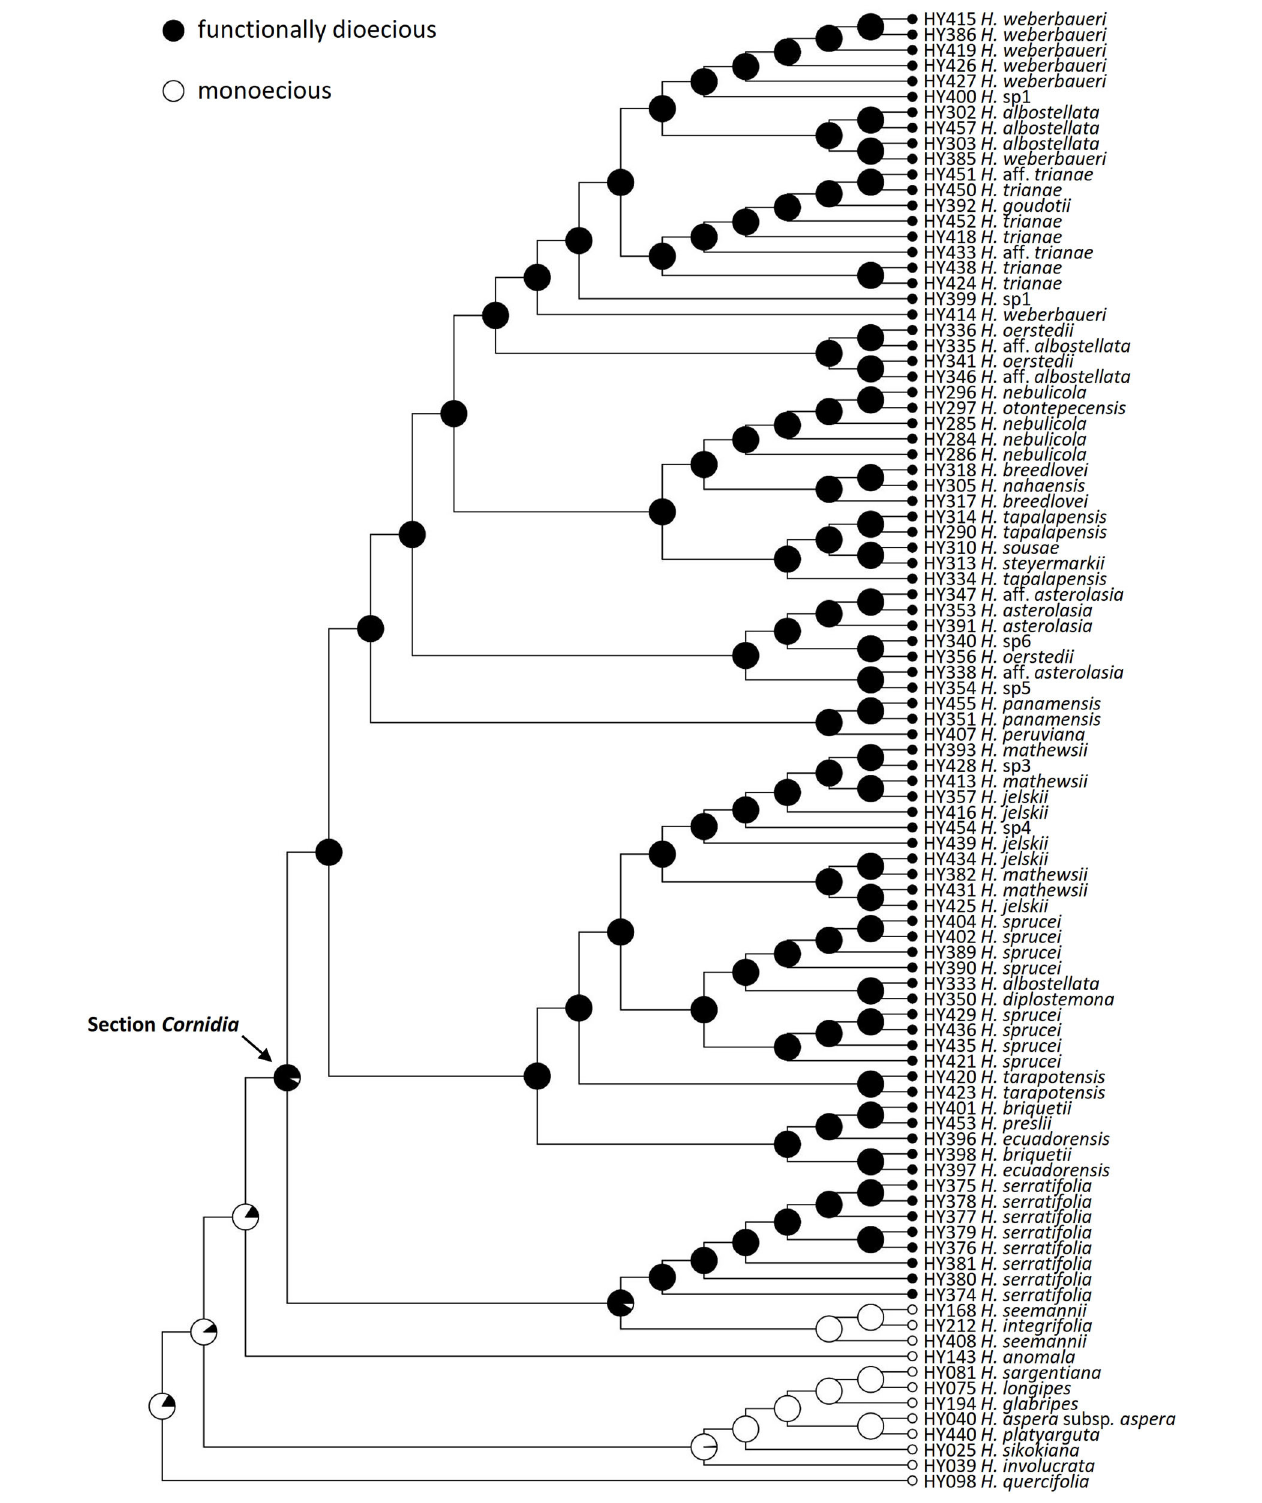
FIGURE 3 | Ancestral reconstruction of sexual dimorphism in Hydrangea section Cornidia , using Bayesian stochastic character mapping. Pies indicate the proportion of functionally dioecious or monoecious from 1,000 simulations on the phylogeny resulting from the combined analysis.